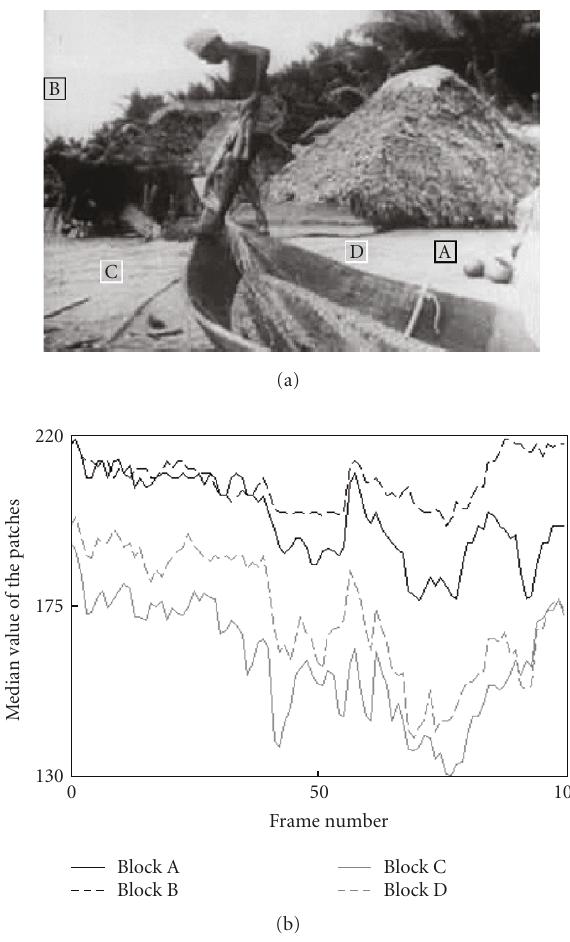
Figure 1: (a) Test sequence Boat used to illustrate spatial variability of flicker measured at selected location. (b) Evolution of the median intensity of the selected